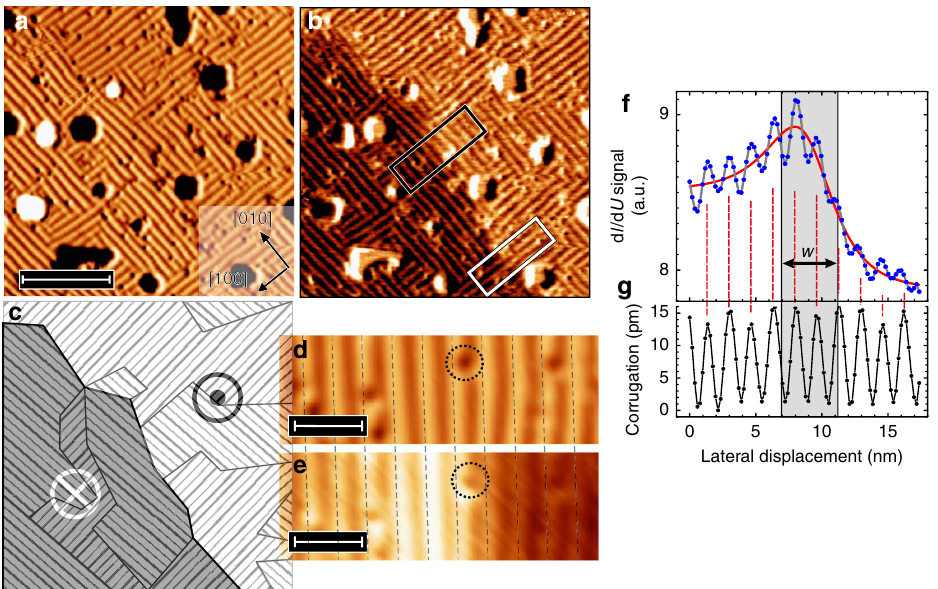
Figure 1 | Coexistence of magnetic domains and a striped phase. ( a ) Topography and ( b ) the simultaneously measured spin-resolved d I /d U map of (1.95 ± 0.02) AL Fe/Rh(001) showing out-of-plane magnetic domains (scan parameters: U ¼ (cid:3) 0.7V, I ¼ 500pA, T ¼ 5K). Scale bar, 15nm. The white and black boxes mark regions where the stripe superstructure is oriented parallel ( q 1 ) or perpendicular ( q 2 ) to the magnetic domain wall, respectively. ( c ) Schematic drawing of the magnetic domain and stripe patterns observed in b . ( d , e ) Zoomed-in topographic and d I /d U image of a location similar to the one shown in the black box in b ( U ¼ (cid:3) 1.0V, I ¼ 500pA). Scale bars, 3nm. ( f , g ) Line sections obtained from e and d , showing spin-resolved d I /d U signal together with topographic corrugation. Fitting the domain wall (red line) as defined in ref. 29 gives a wall width w ¼ (4.32 ± 0.35)nm. It is noteworthy that the presence of the domain wall does not significantly influence the modulation of the stripe superstructure, as indicated by the equally spaced dashed red lines.